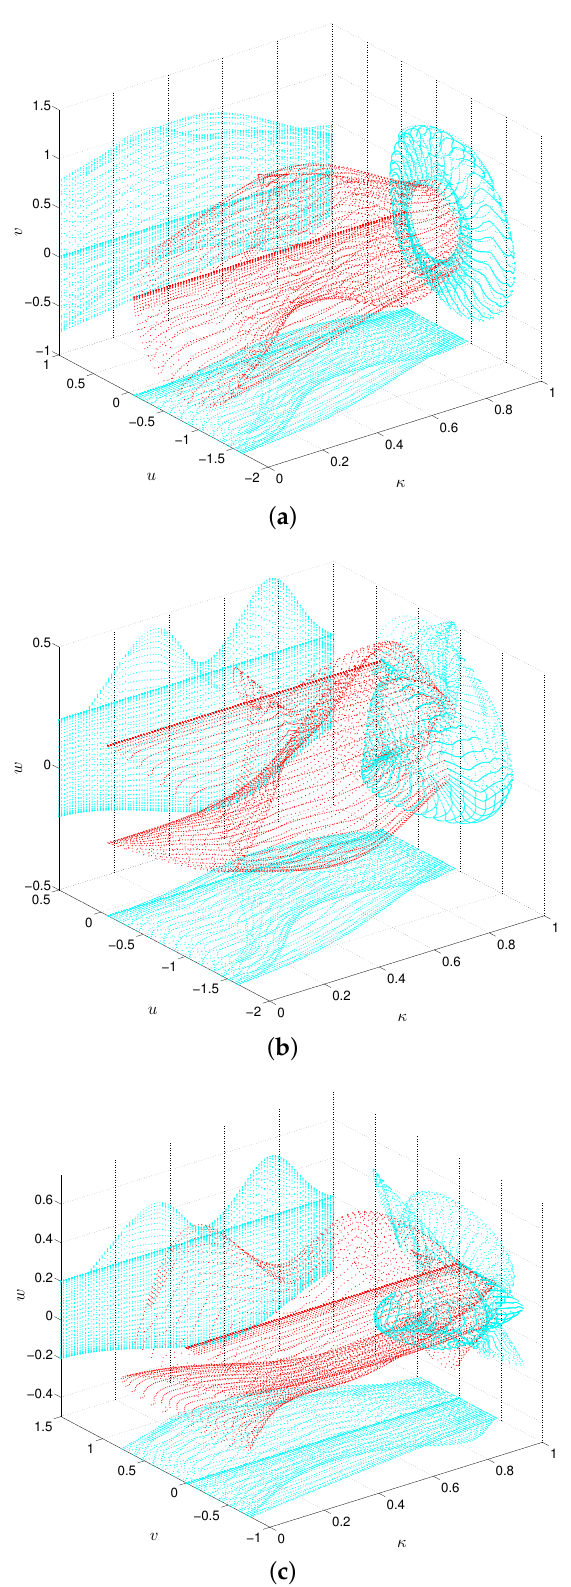
Figure 6. ( a – c ) Bifurcation diagrams of the arbitrary sum κ of the masses of the primaries in the frames κ uv , κ uw and κ vw , respectively, when µ m = 0.48785, q 1 = 0.9988, q 2 = 0.9985, α 1 = 0.024, α 2 = 0.02, α = 1.001, β =